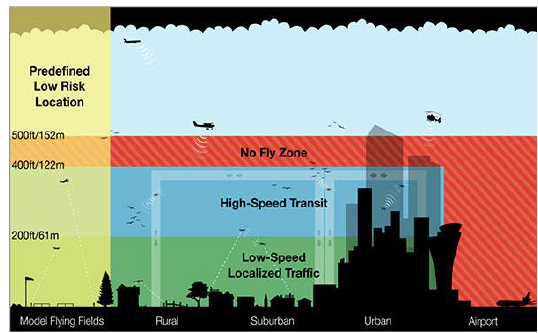
Figure 1. Amazon’s non-integrated airspace for unmanned aerial vehicles (UAVs) [6].